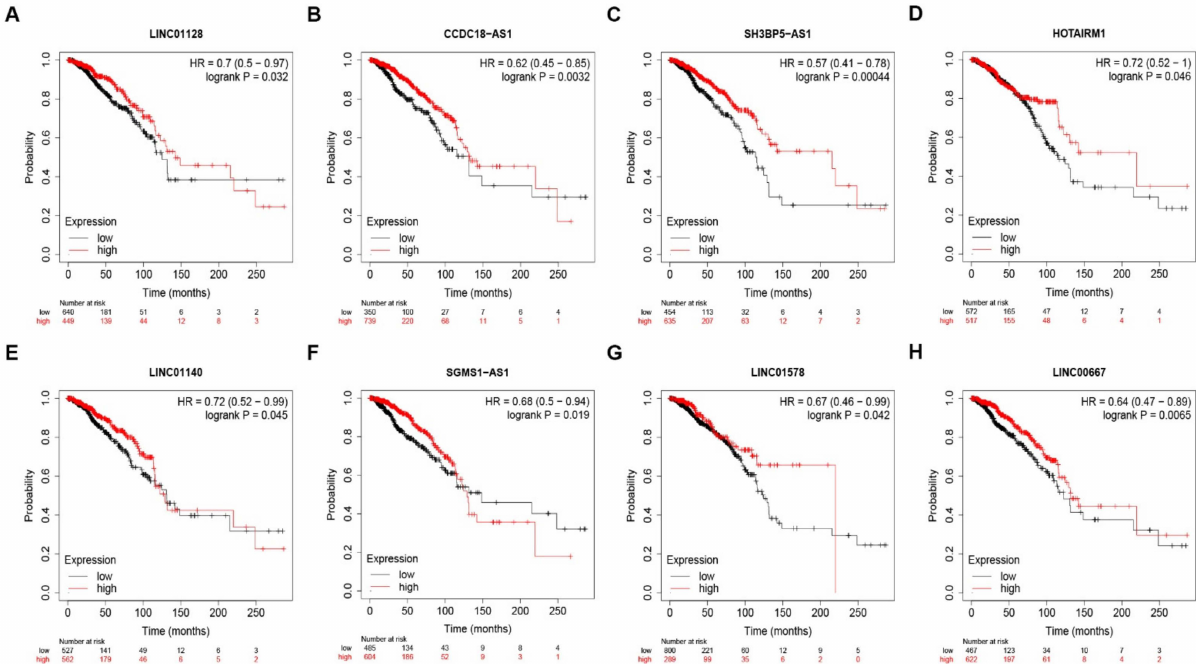
Figure 7. Survival analysis for potential lncRNAs of miR-137 or miR-429 in breast cancer. ( A ) The prognostic value of LINC01128 ( A ), CCDC18-AS1 ( B ), SH3BP5-AS1 ( C ), HOTAIRM1 ( D ), LINC01140 ( E ), SGMS1-AS1 ( F ), LINC01578 ( G ) and LINC00667 ( H ) in breast cancer. “ p < 0.05” was considered as statistically